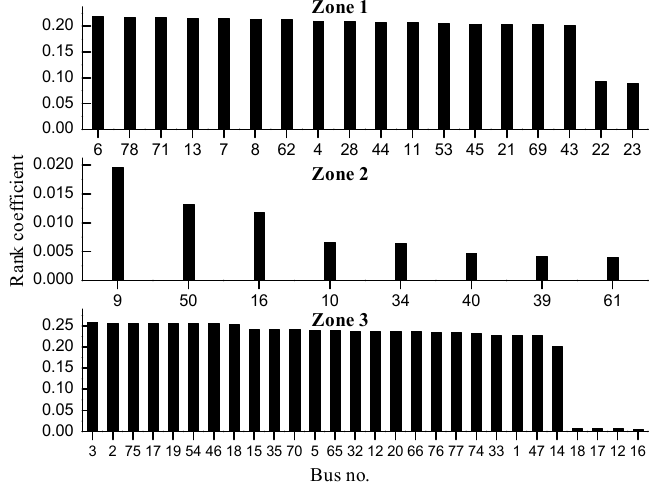
Figure 10. Rank correlation coefficient of DV and SV.